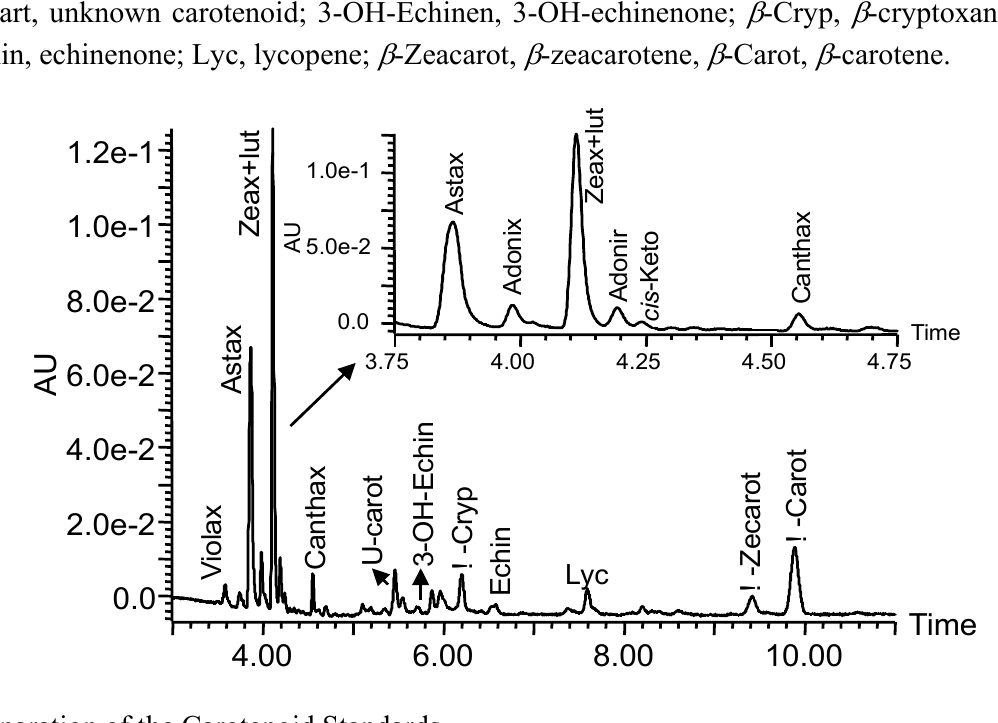
Figure 1. Carotenoid profile of the transgenic maize line TM2. Abbreviations: Violax, violaxanthin; Astax, astaxanthin; Zeax, zeaxanthin; Lut, lutein; Adonix, adonixanthin; Adonir, adonirubin; cis -Keto, cis -unknown ketocarotenoid; Canthax,